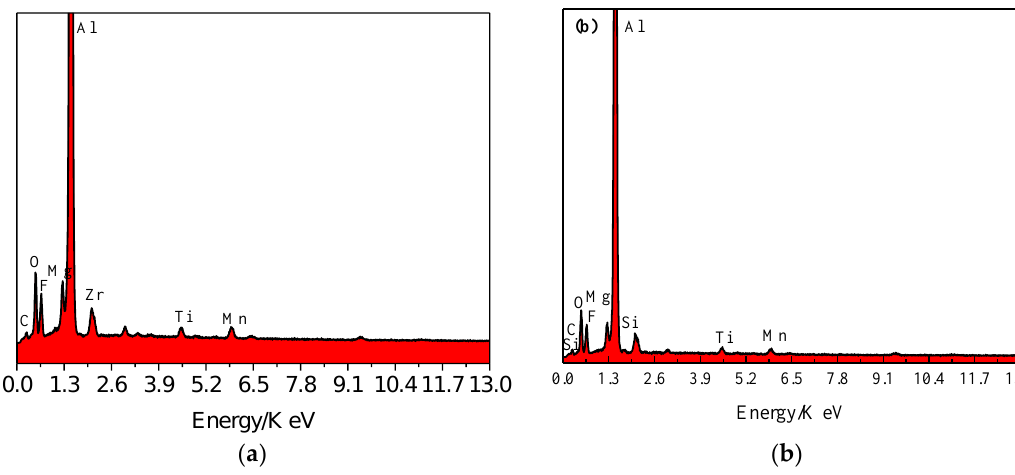
Figure 2. EDS spectra of conversion-coated 5052 aluminum alloy: ( a ) before FAS-17 modification, ( b ) after FAS-17 modification.